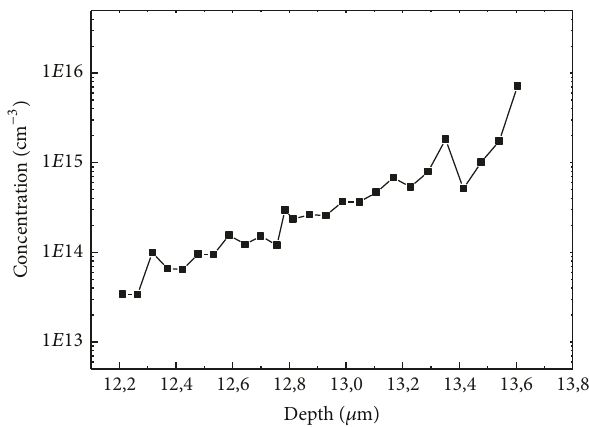
Figure 4: The distribution of aluminium concentration versus 𝑊(𝑉) according to 𝐶 - 𝑉 data in high-resistance layer of the sample 4 H -SiC ⟨ Al ⟩